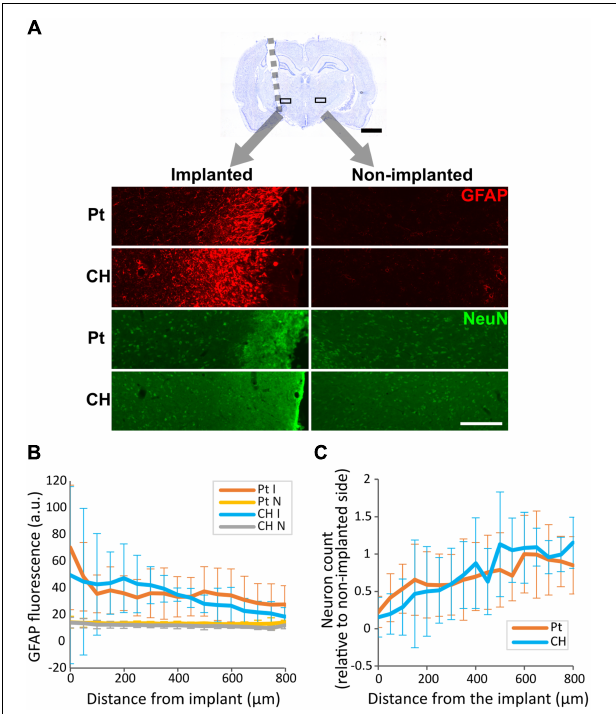
FIGURE 10 | Tissue response and neural survival at the site of implantation in the rat brain implanted with conductive hydrogel-coated (CH) or uncoated platinum (Pt) electrodes. The brains were sectioned and immunostained for glial fibrillary acidic protein (GFAP) and neuronal nuclei (NeuN) to assess tissue response and neural survival (10 rats for Pt and 6 rats for CH). All graphs represent mean ± SD. (A) Representative images of GFAP and NeuN immunostaining in the rat brains implanted with Pt and CH electrodes. Scale bar, 200 µ m. (B) GFAP fluorescence was significantly higher near the implant ( p < 0.001), but was not significantly affected by CH coating (I, implanted; N , non-implanted; p = 0.387, two-way ANOVA). (C) The relative number of NeuN positive cells (neurons) to non-implanted were significantly reduced near the implant compared to the area further away from the implant ( p < 0.001), but was not significantly affected by CH coating ( p = 0.352, two-way ANOVA).